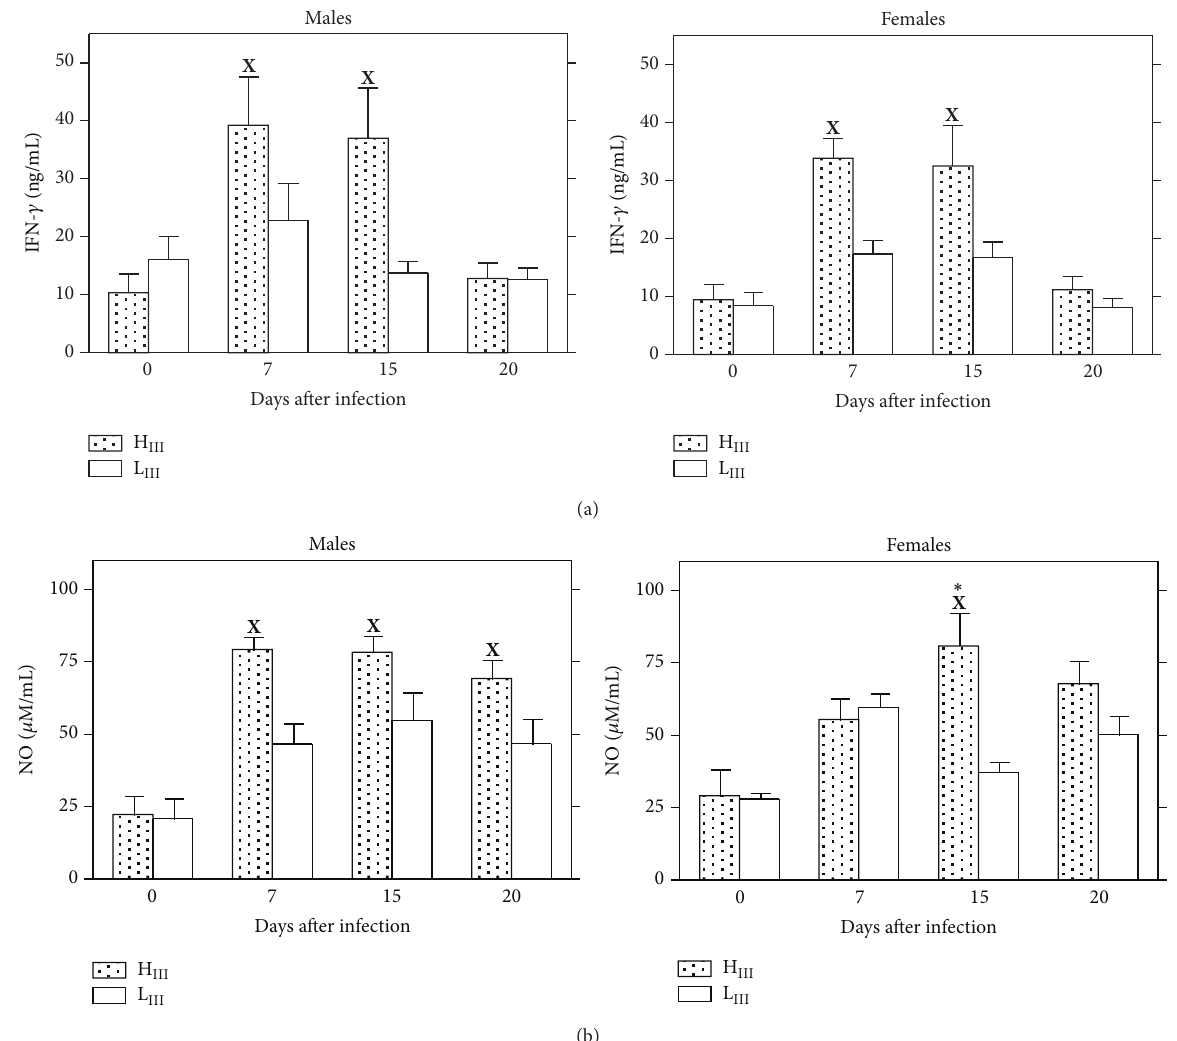
Figure 5: IFN- 𝛾 (a) and nitric oxide (NO) (b) production by lymph node (a) and peritoneal cells (b) during the acute phase of infection with 10 2 T. cruzi parasites (CL strain) in outbred H III and L III mice. Cells were stimulated in culture with ConA (2.5 𝜇 g/mL) for 48 h. Results are expressed as the means ± SE of each group ( 𝑛 = 6 ). Significant differences between infected and control mice ( X ) or between lines ( ∗ ) evaluated by ANOVA followed by Tukey multiple comparison tests are indicated when 𝑃 < 0.05